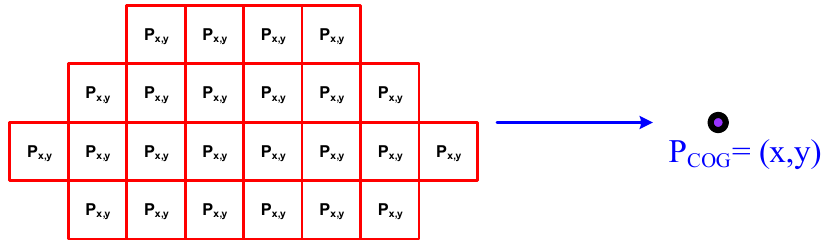
Figure 3. Pixels forming an example of a marker area in a measurement point A12.